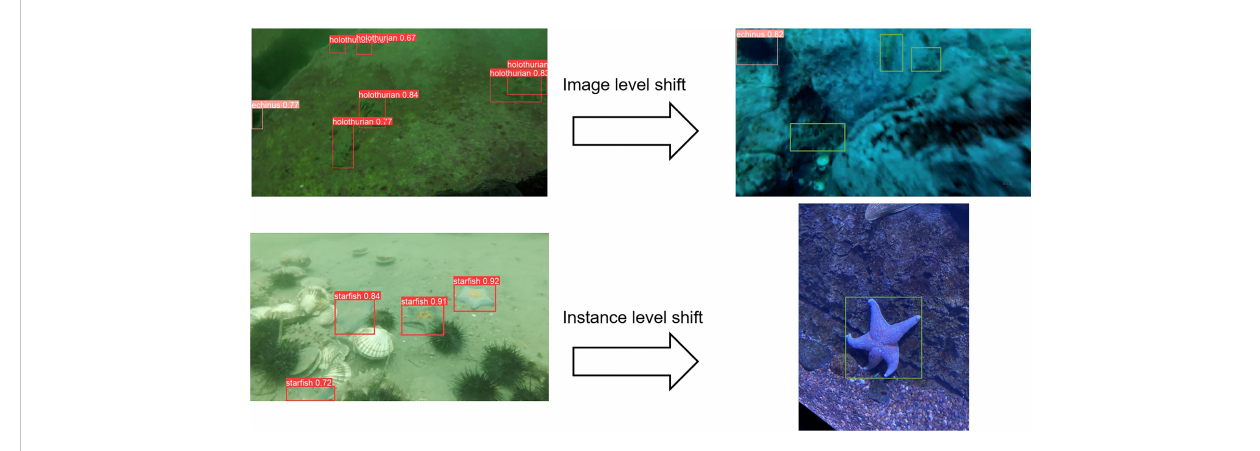
FIGURE 1 Two different underwater domain shifts and cross-domain performance degradation of